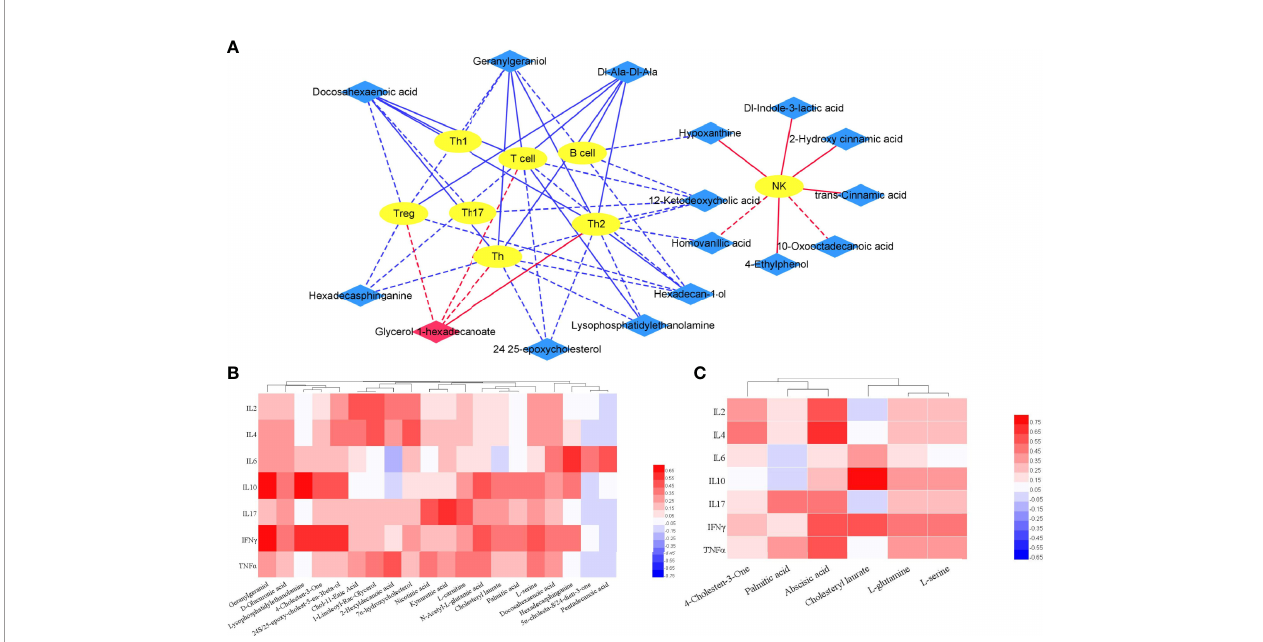
FIGURE 7 | Correlation of differential metabolites and clinical features. (A) Integrative network of associations re fl ecting the interactions of differential metabolites (PsA vs HC) and lymphocyte subpopulation via Cytoscape (3.8.2). Network revealed both signi fi cant ( p < 0.01) and suggestive associations (0.01< p < 0.05) between differentially abundant metabolites and lymphocyte subpopulation in PsA. Yellow oval nodes represent immune cells, red and blue diamond nodes represent the increase and decrease of metabolites in PsA, respectively. Lines connecting nodes indicate positive (red) or negative (blue) correlations. The full lines and dotted lines indicate signi fi cant correlation and suggestive correlation respectively. (B) Correlation of differential metabolites (PsA vs HC) and cytokines in PsA; (C) Correlation of differential metabolites (PsA vs RA) and Cytokines in